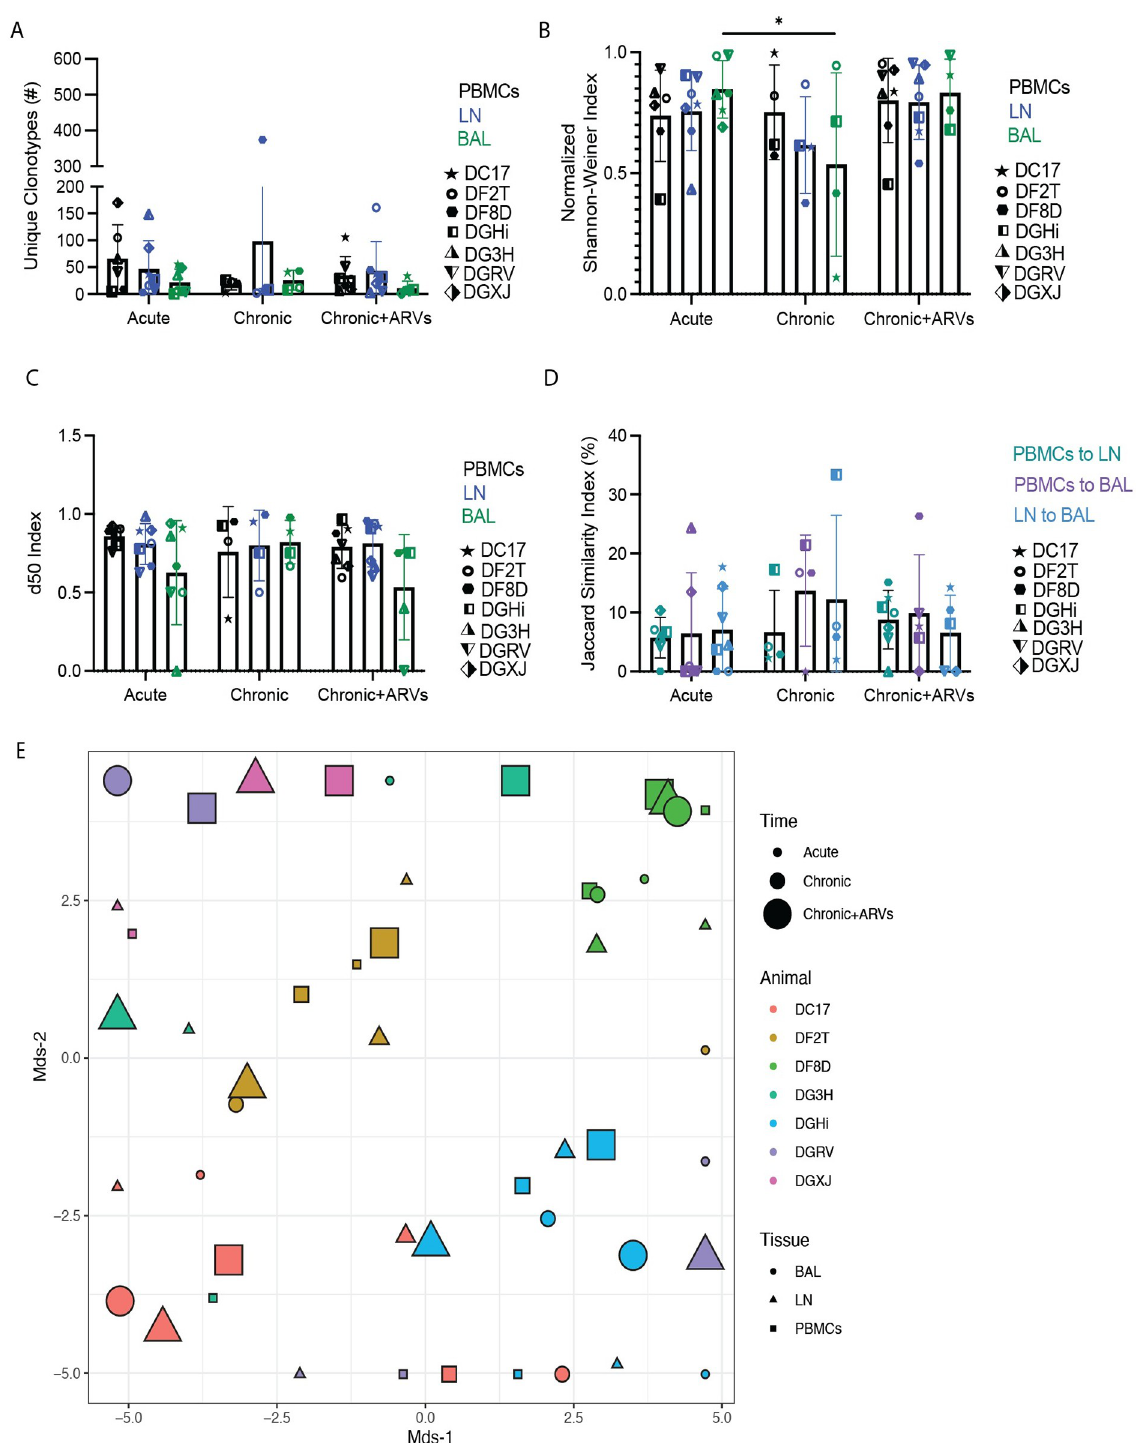
Fig 2. SIV-specific CD8 + T cells exhibit similar TCR diversity and similarity throughout SIV infection. PBMCs, LN biopsies and BAL were sampled from SIVmac239X or SIVmac239-infected rhesus macaques during acute infection, chronic infection and after 2–6 months of ARV treatment. (A) The number of unique clonotypes in multiple anatomical sites at all timepoints. (B) The normalized Shannon-Weiner diversity index for the TCR repertoires of all tissues throughout SIV infection. (C) The d50 diversity index for the TCR repertoires of all tissues throughout SIV infection. (D) The Jaccard similarity index for comparisons between each tissue’s TCR repertoire. In (A-D), data is represented by mean and SD, with each individual animal represented by a unique symbol. (E) MDS plot of the TCR repertoires of each animal, tissue and timepoint throughout infection. Two-way ANOVA was used to determine statistical significance for panels A to D. n = 7 animals.